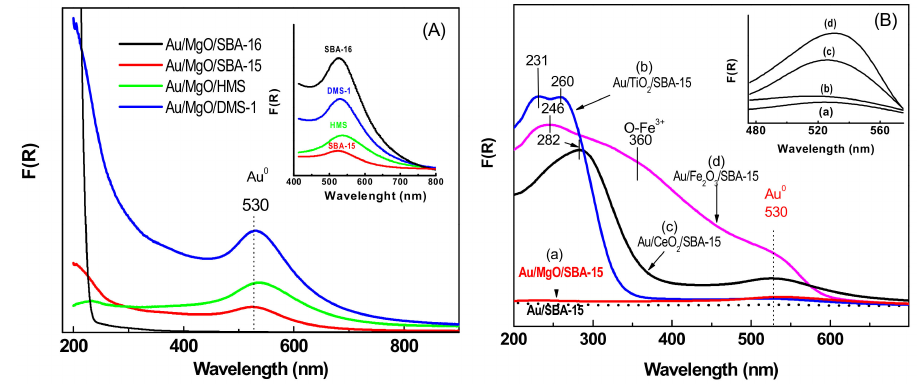
Figure 6. DRS UV-vis spectra of the as-prepared Au/MgO/MSM ( A ) and Au/MO x /SBA-15 ( B )